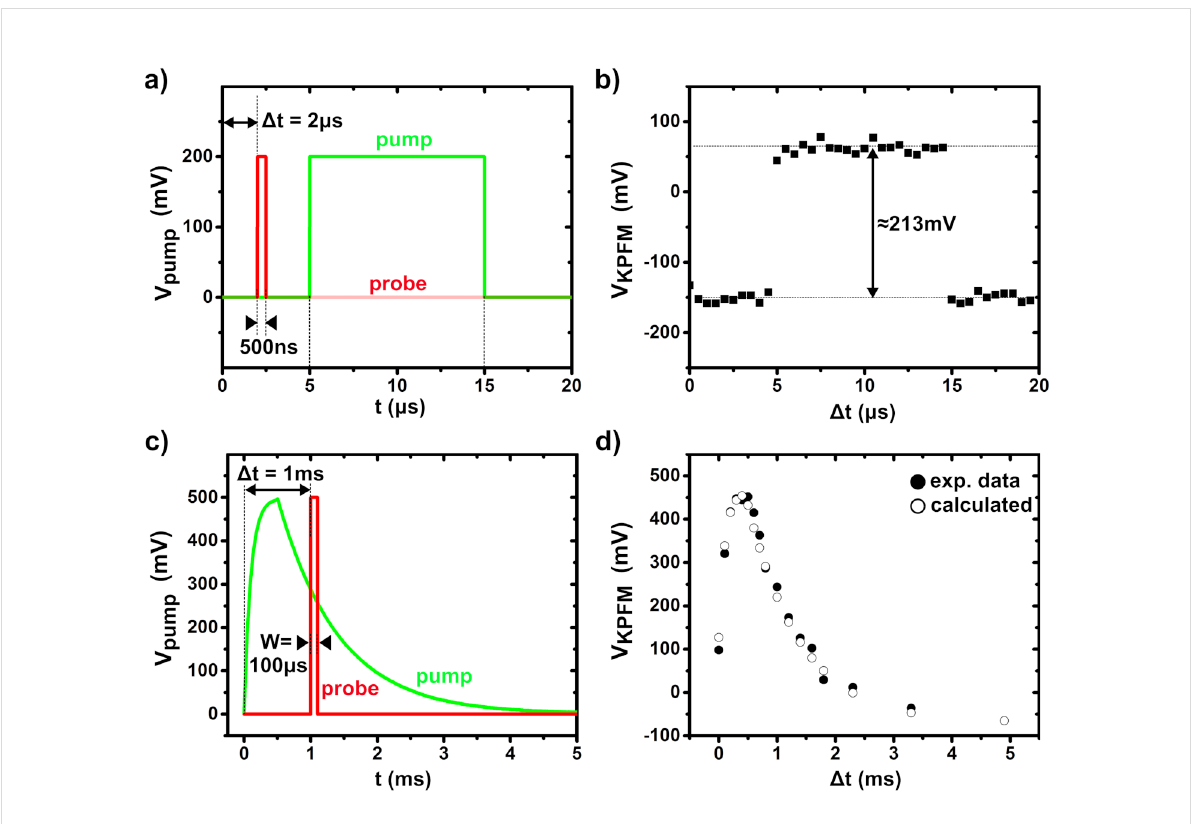
Figure 4: (a, b) pp-KPFM single-point spectroscopy of an electrical square-wave signal of 10 µs (pump, amplitude 200 mV, period 20 µs). (a) Plot of the pump and probe signals as a function of time for Δ t = 2 µs. The pump signal was recorded using the oscilloscope. NB: the y -scale is shown for the pump only. The probe-time window was set to 500 ns. (b) KPFM compensation potential as a function of Δ t . 40 delay values evenly distributed within the time window of 20 µs as defined by the pump signal period were used to record that spectrum. The integration time per pixel was 4 s. (c, d) pp-KPFM single-point spectroscopy measurement of a “surge pulse” of 5 ms (pump, amplitude 500 mV). (c) Plot of the pump and probe signals as a function of time for Δ t = 1 ms. The probe window was set to 100 µs. (d) KPFM compensation potential (average of 5 spectra) as a function of Δ t (filled circles). 17 delay values irregularly distributed within the time window of 5 ms were used. The integration time per pixel was set to 1 s, preceded by a pre-integration time of 2 s. The open circles represent calculated values obtained by integrating the pump signal over the probe-time window and by applying a correction factor to correct the impedance mismatch. The calculated data have been shifted along the y -axis to ease the comparison with the experimental results. This y -shift with respect to the zero baseline results from the difference of the tip–substrate work